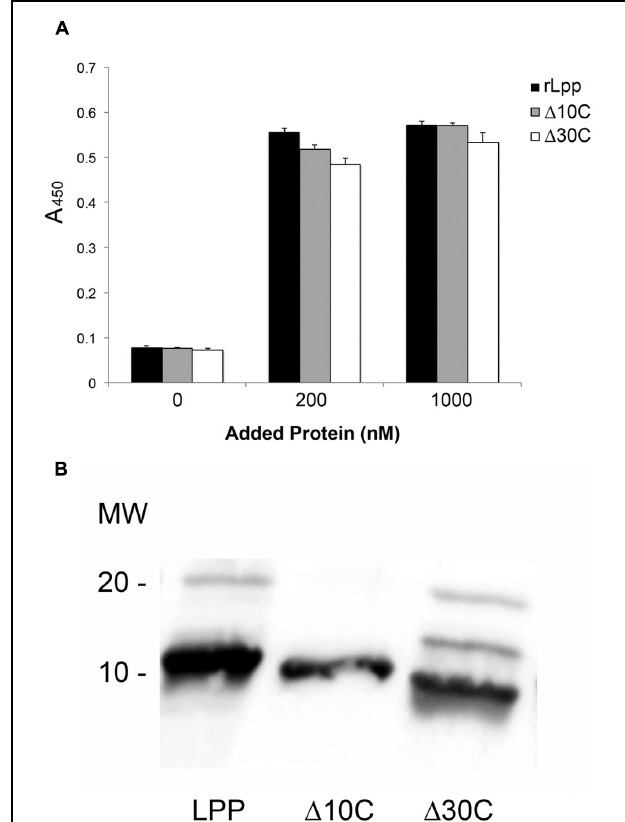
FIGURE 3 | Lpp binds to Plg independently of the Lpp C-terminal domain. ELISA was performed to analyze the binding between Plg and Lpp C-terminal truncations (A) , and a Western blot was performed to verify that the mutants used retained receptivity to the α Lpp antibodies generated during this study (B) . No statistically significant differences were observed between Lpp and C-terminal truncation mutants’ binding to human